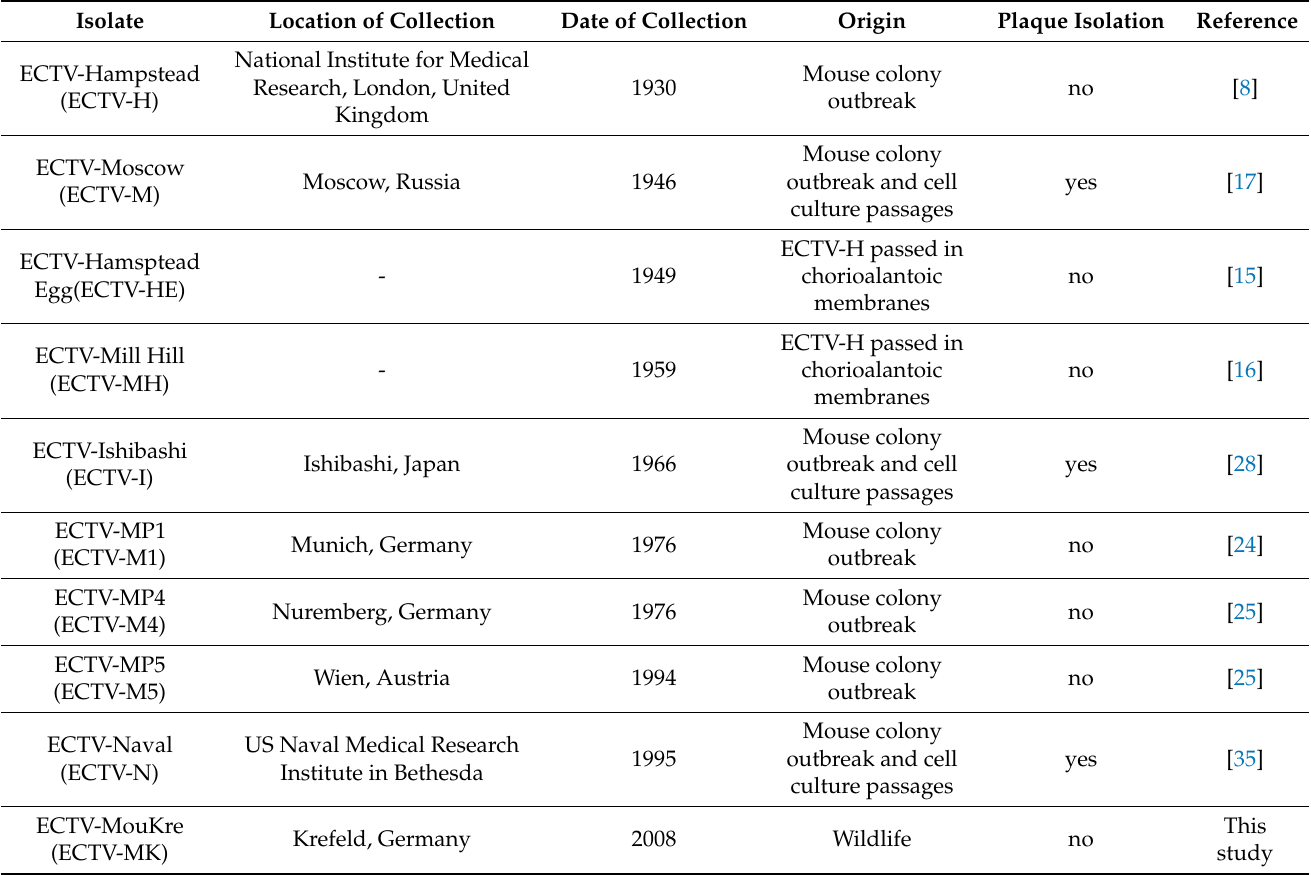
Table 1. ECTV isolates and strains used in this